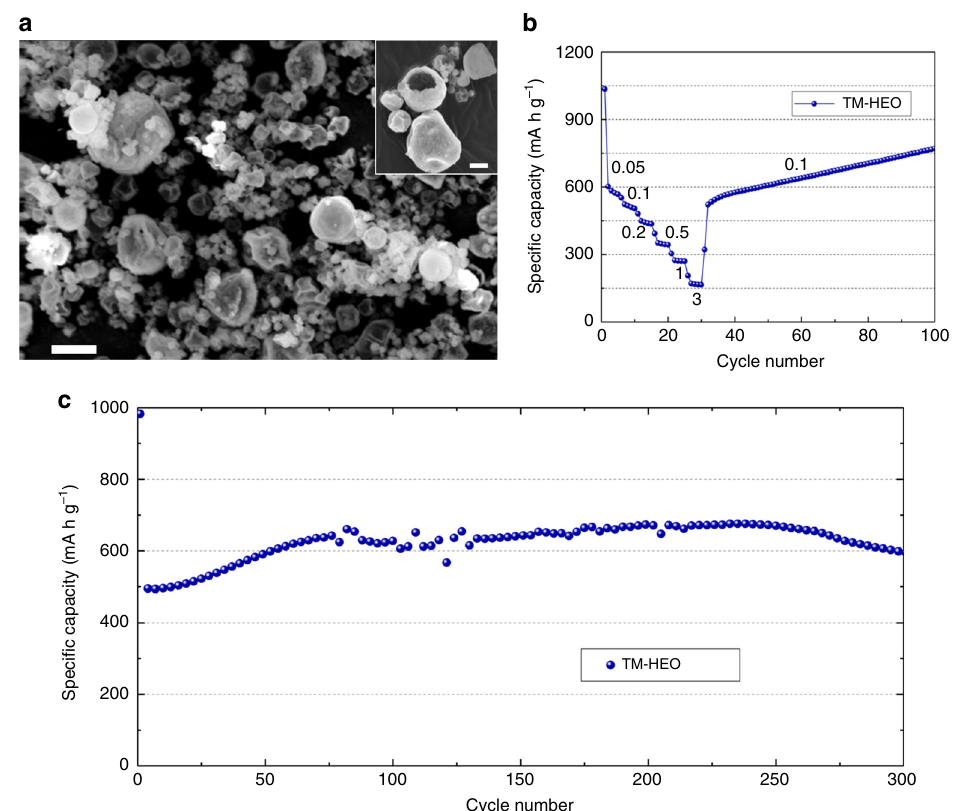
Fig. 1 TM-HEO particles and their speci fi c capacities. a SEM micrograph of the as-synthesized TM-HEO powder with typical particle sizes from the nano-to- micrometer range. The inset shows that the powder contains both hollow and fi lled spheres. The scalebars shown in a and the inset correspond to 2 µ m and 1 µ m, respectively. b Galvanostatic rate capability test (current values given in units of A g ‒ 1 ). The capacity decreases as the speci fi c current is increased stepwise up to 3 A g ‒ 1 , but it recovers at 0.1 A g ‒ 1 and even increases after 100 cycles to 770 mAh g ‒ 1 . c Long-term cycling performance at 0.2 Ag ‒